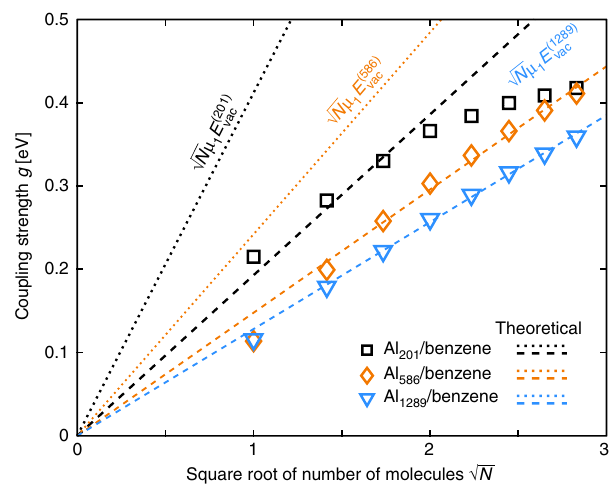
Fig. 3 Coupling strengths of the nanoparticle-molecule systems. Coupling strengths g for different numbers N of molecules placed 3 Å above the nanoparticle. The symbols denote fi tted g values from the data of Fig. 2. The dotted lines mark the ideal theoretical coupling strengths g ¼ while the dashed lines mark the ideal dependence multiplied with ef fi ciency factors η of η 201 = 0.47, η 586 = 0.61, and η 1289 = 0.78 (see Fig. 4a and its in-text description for